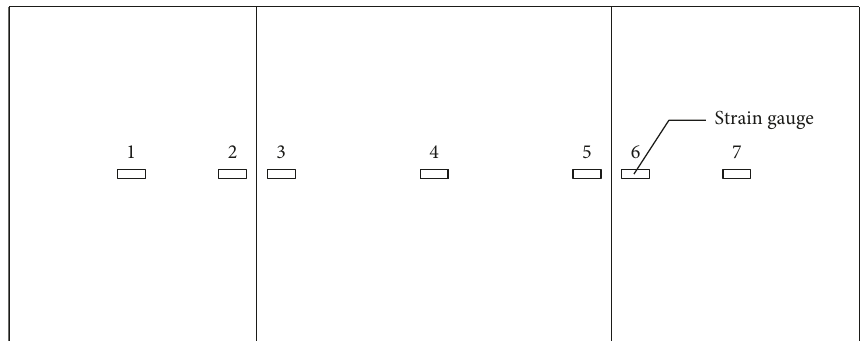
Figure 7: Layout of strain gauges in the concrete surface.